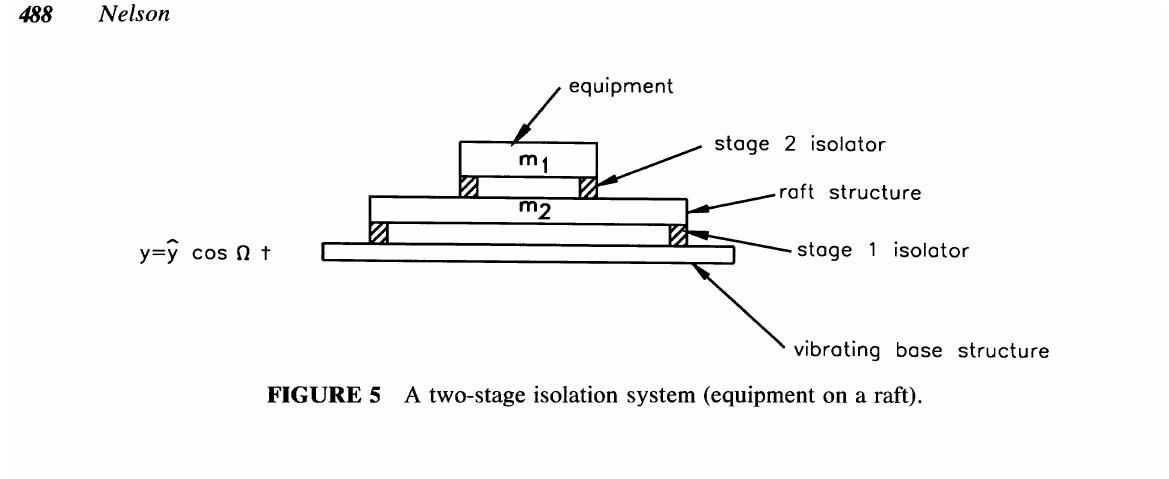
FIGURE 5 A two-stage isolation system (equipment on a raft).